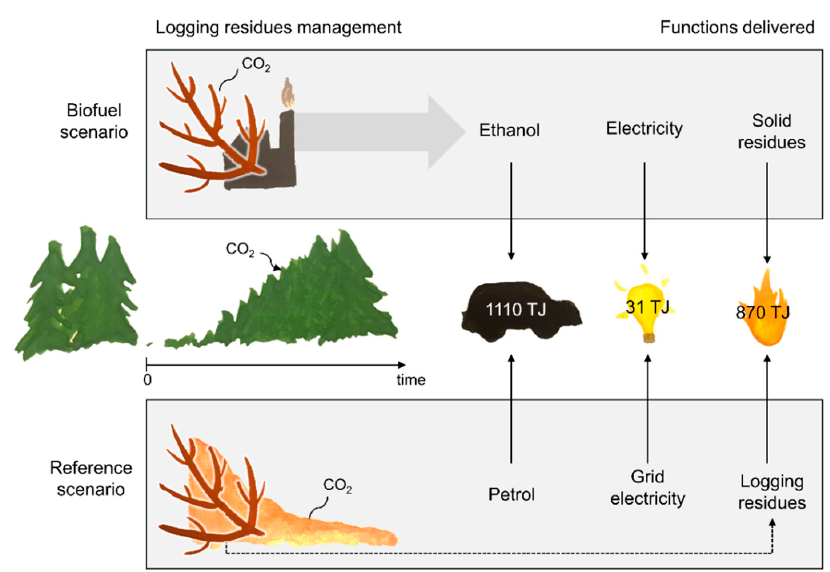
Figure 1. Schematic description of the biofuel scenario for logging residues (top), and the functionally equivalent reference scenario (bottom). The scenarios depart from the same forestry and deliver the same functions but differ in terms of how logging residues are managed (utilization for biofuel production or leave at the site) and how the functions are provided (from biomass, or fossil fuels and grid electricity). The broken arrow illustrates that a part of the residues is used for heating in the reference scenario. TJ: terajoules, CO 2 : carbon dioxide.